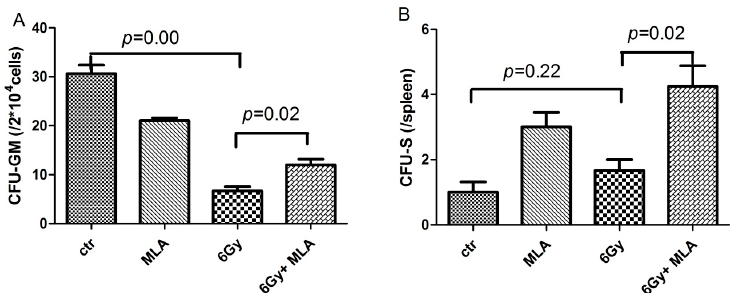
Figure 4. Effects of MLA on the CFU-GM frequency and the CFU-S number. ( A ) The CFU-GM frequency of BMMNCs. Before the mice were exposed to 6 Gy TBI, they were treated with either vehicle or MLA (10 mg/kg) each day three times. Sham-irradiated control mice and MLA-treated mice were also included. BMMNCs were collected and counted after the mice were euthanized nine days after exposure to 6 Gy TBI. The cells were cultured in MethoCult GF M3534 methylcellulose medium for CFU-GM analysis; ( B ) Number of CFU-S. The number of CFU-S per spleen was counted after the spleens were fixed in Bouin’s solution for 24 h. Results are expressed as the mean ± SEM ( n = 5 for each group). The p value shows the difference compared with the IR group.